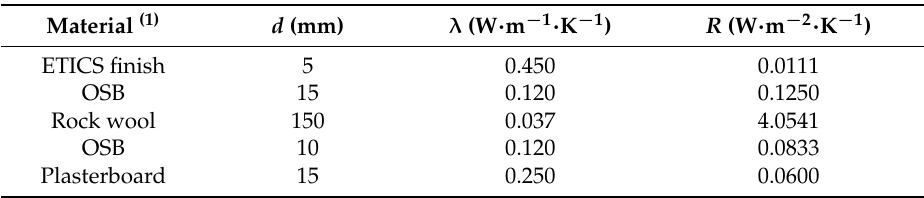
Table 2. Thicknesses and thermal characteristics of the modelled material layers for accuracy verification against EN ISO 6946 [15].